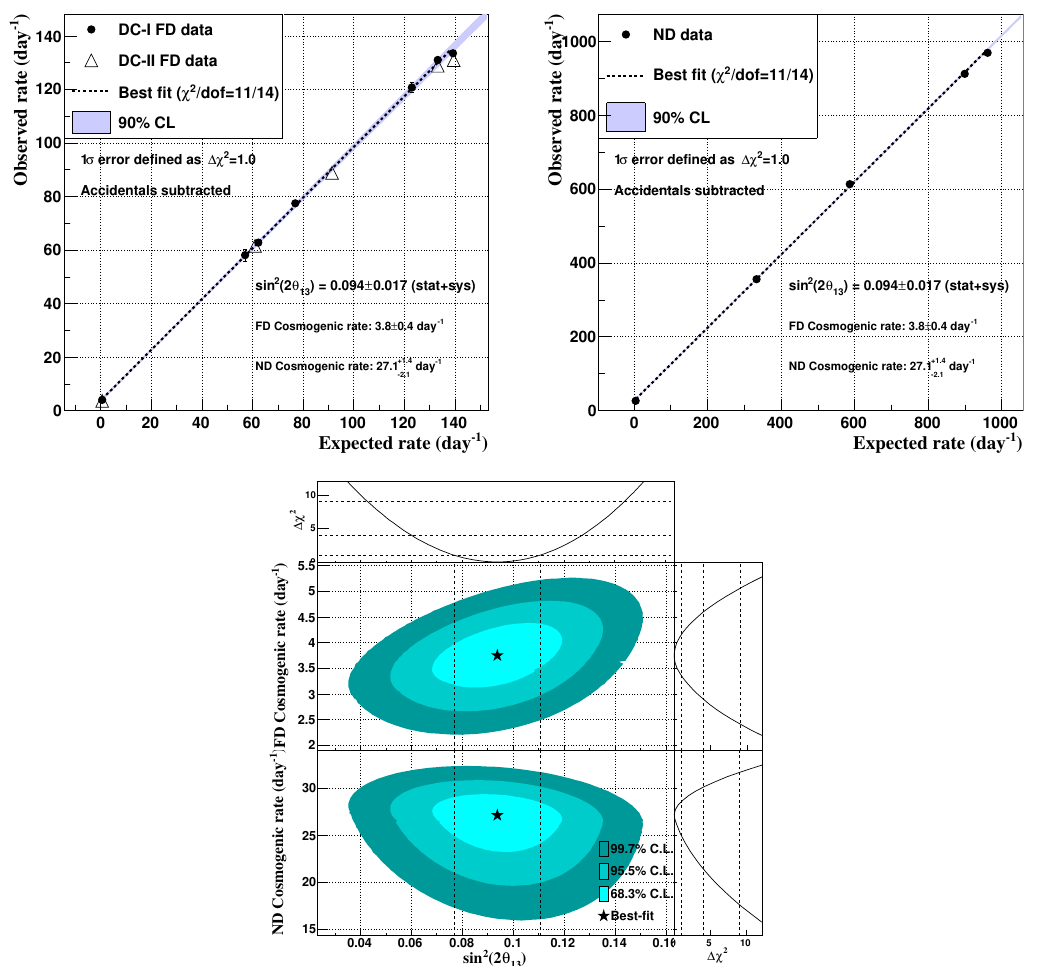
Figure 4 . RRM (sin 2 (2 θ 13 ) , B FD , B ND ) fit results. The upper plots show the observed rates versus the expected rates in the FD (left) and the ND (right), superimposed to the best-fit model (dashed line). The statistical errors, not visible, are at the level of ∼ 1% ( ∼ 0 . 4% ) in the FD (ND). The bottom plot shows the 68.4%, 95.5% and 99.7% C.L. regions for the three parameters and the one-dimensional projections of ∆ χ 2